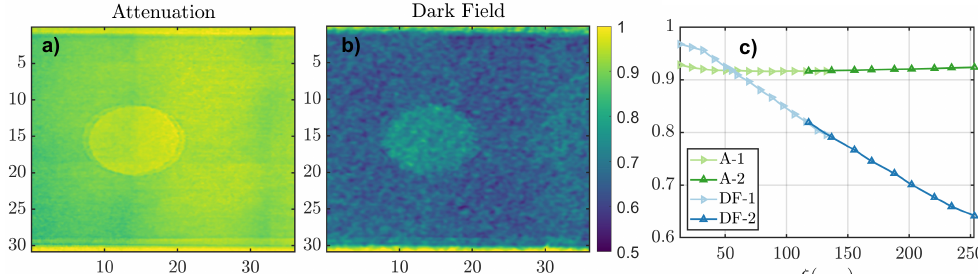
Figure 3. ( a ) Attenuation contrast image of the stack of electrical steel sheets. ( b ) Dark-field contrast image respective to graph ( a ). Both graphs are for the longest autocorrelation length probed. Note that the color bar is the same for both images, and the unit in the x- and y-axes is in mm. ( c ) Attenuation contrast (green lines) and dark-field contrast (blue lines) plots as a function of autocorrelation length. The light colored lines ( − 1 suffix) are obtained by SG imaging with the regular pattern, whereas the dark colored lines ( − 2 suffix) are obtained with the inverse